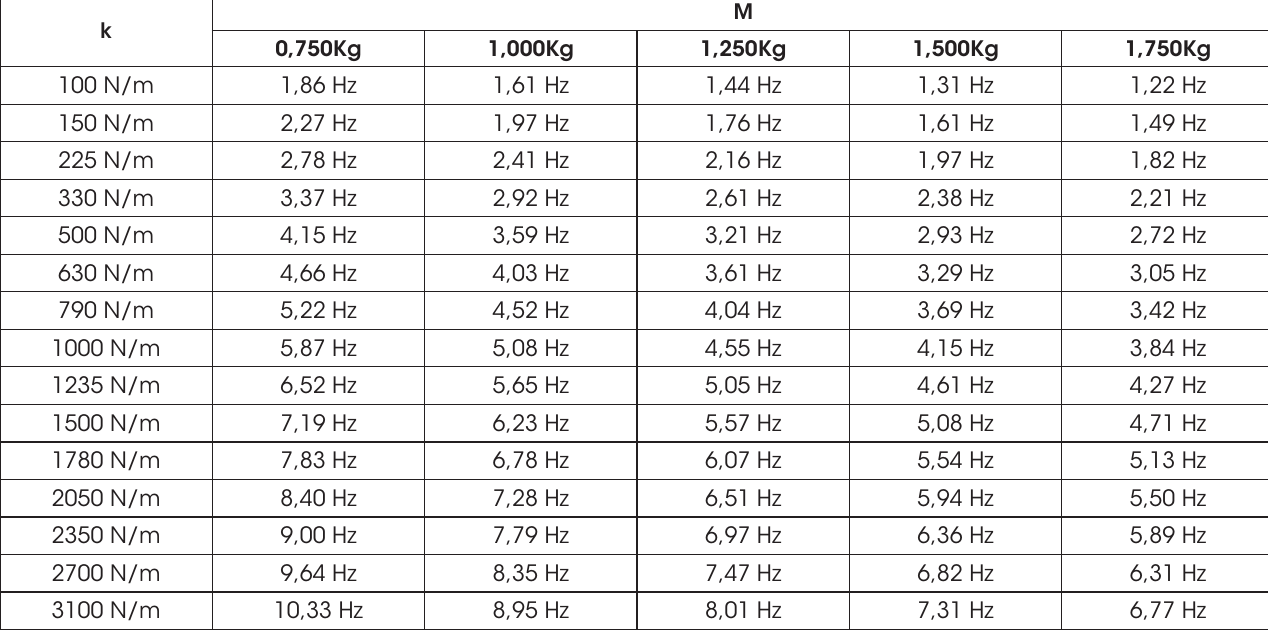
Possible rectified natural frequencies for the mass-spring combinations of the standard TMD